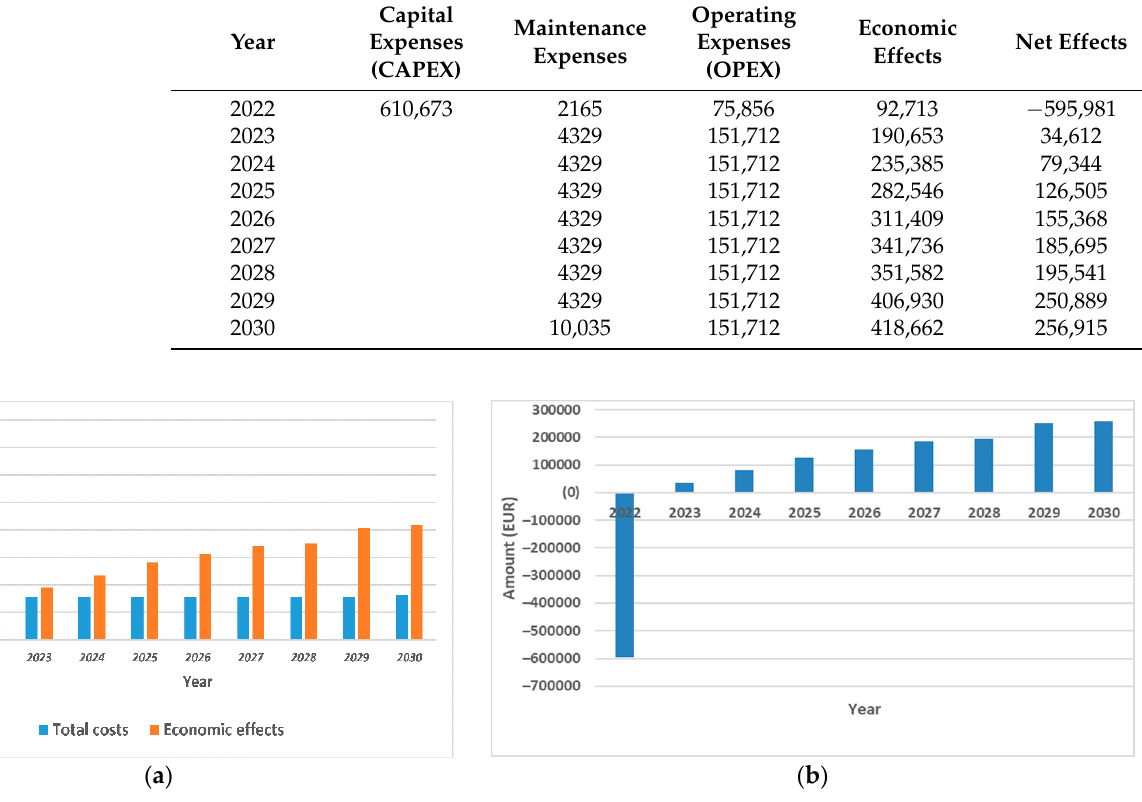
Figure 4. Relationship between total costs and economic effects of the project. ( a ) Total costs and economic effects; ( b ) net effects (difference between total costs and economic effects). Table 14. Dynamic efficiency indicators of economic feasibility of the project.